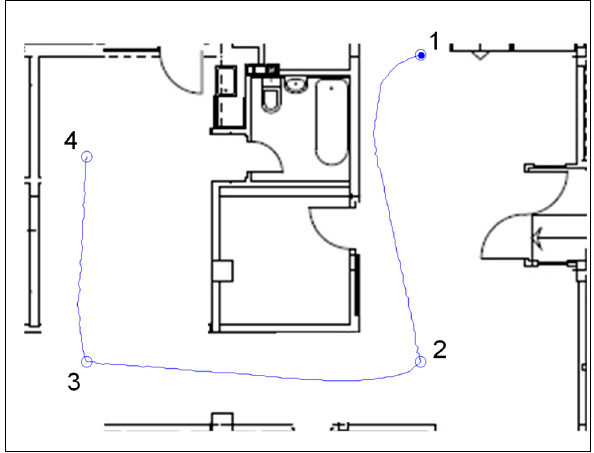
Figure 6. Robot trajectories on a ground plan.